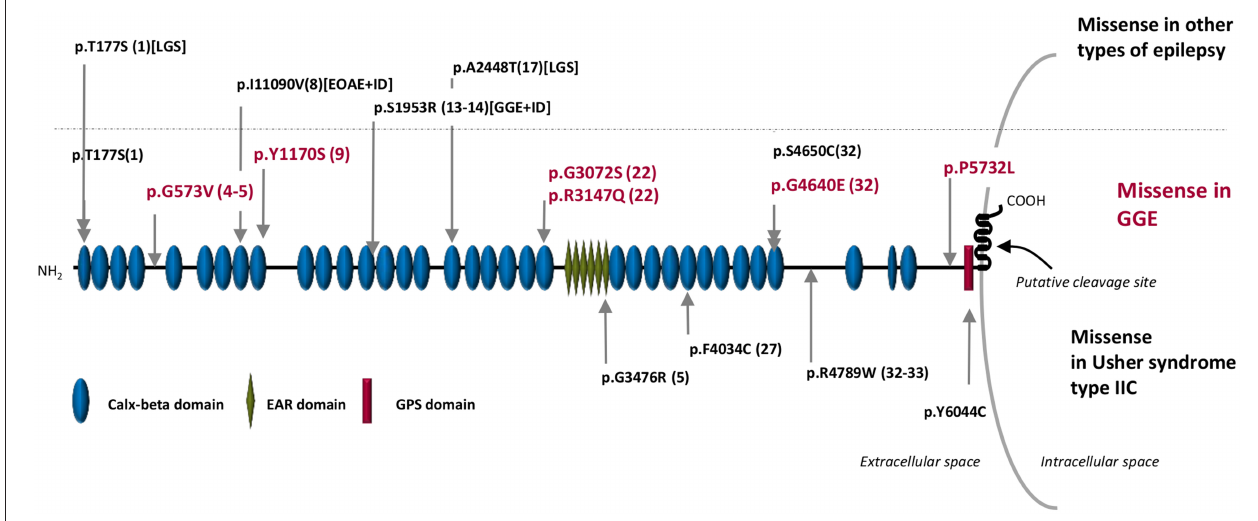
FIGURE 2 | Schematic representation of the ADGRV1 protein structure. In the upper part of the figure: in red are the missense variants associated with GGE in Sudanese families (this publication), and in black are the missense variants associated with other types of epilepsy in the Australian cohort reported by Myers et al. ( 18). The dotted line separated the variants associated with GGE (bottom) from those associated with other types of epilepsy (up). In the bottom part of the figure are the rare pathogenic missense variants reported in Usher syndrome type IIC. The numbers inside brackets indicate the calx-beta domains sequential order. GGE, genetic generalized epilepsies; EOAE, early onset absence epilepsy; LGS, Lennox–Gastaut syndrome; ID, intellectual